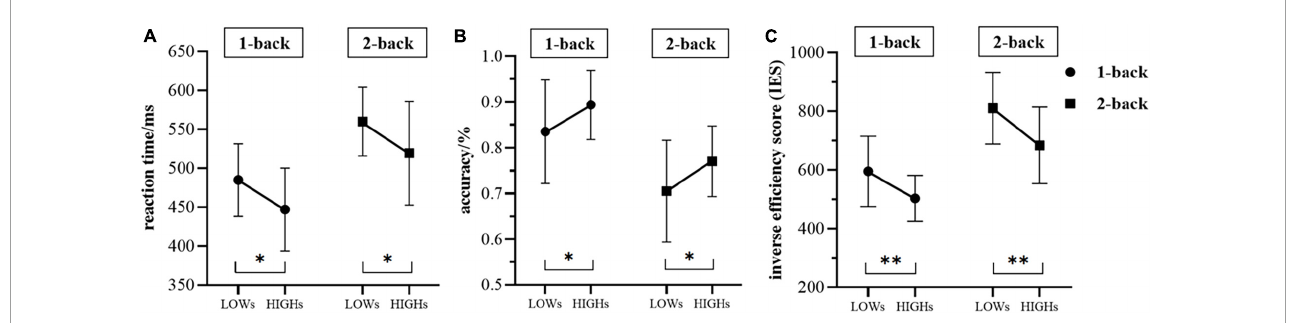
FIGURE3 The differences in reaction time (A) , accuracy (B) , and the inverse efficiency score (IES) (C) between the two groups during the 1-back and 2-back tasks. “LOWs” and “HIGHs” refer to the test performance of subjects in the low rMSSD group and the high rMSSD group, respectively. Whiskers are standard deviation. LOWs, the low rMSSD group; HIGHs, the high rMSSD group. Asterisks indicate the level of statistical significance of t -tests. ∗ p < 0.05, ∗∗ p <